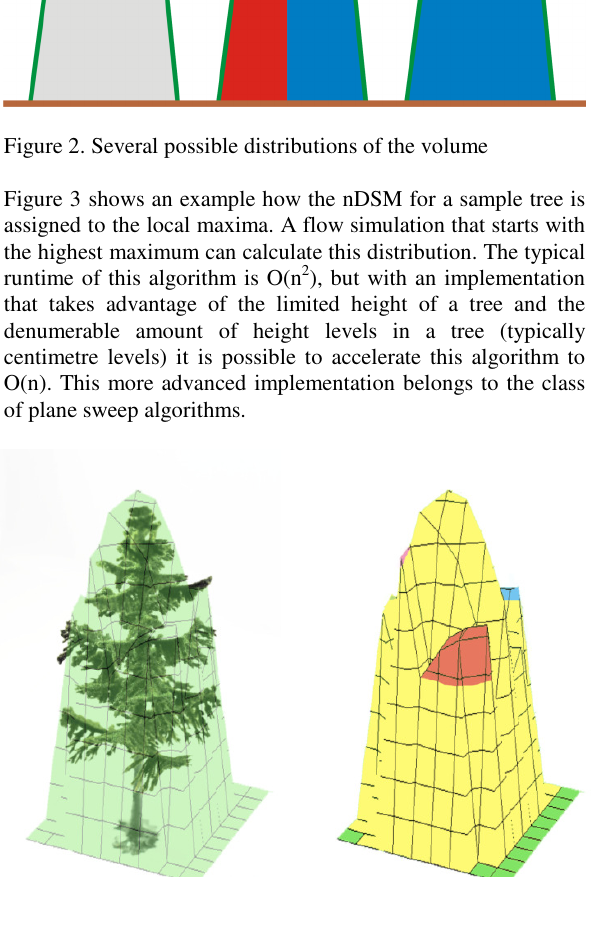
Figure 3. The distribution for the nDSM of a single